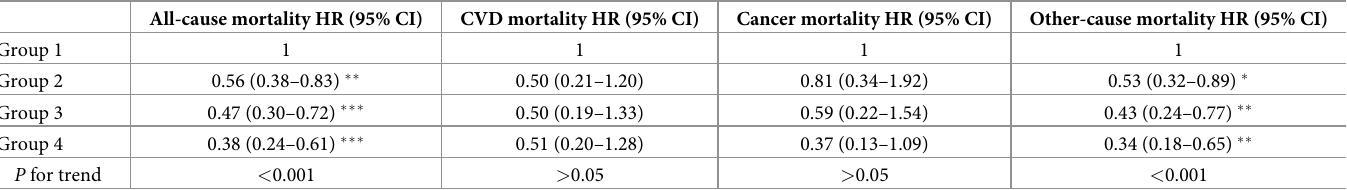
Table 4. All-cause and cause-specific mortality risk among the four groups of study participants by glycohemoglobin (HbA1c) and dietary magnesium intake. All-cause mortality HR (95%